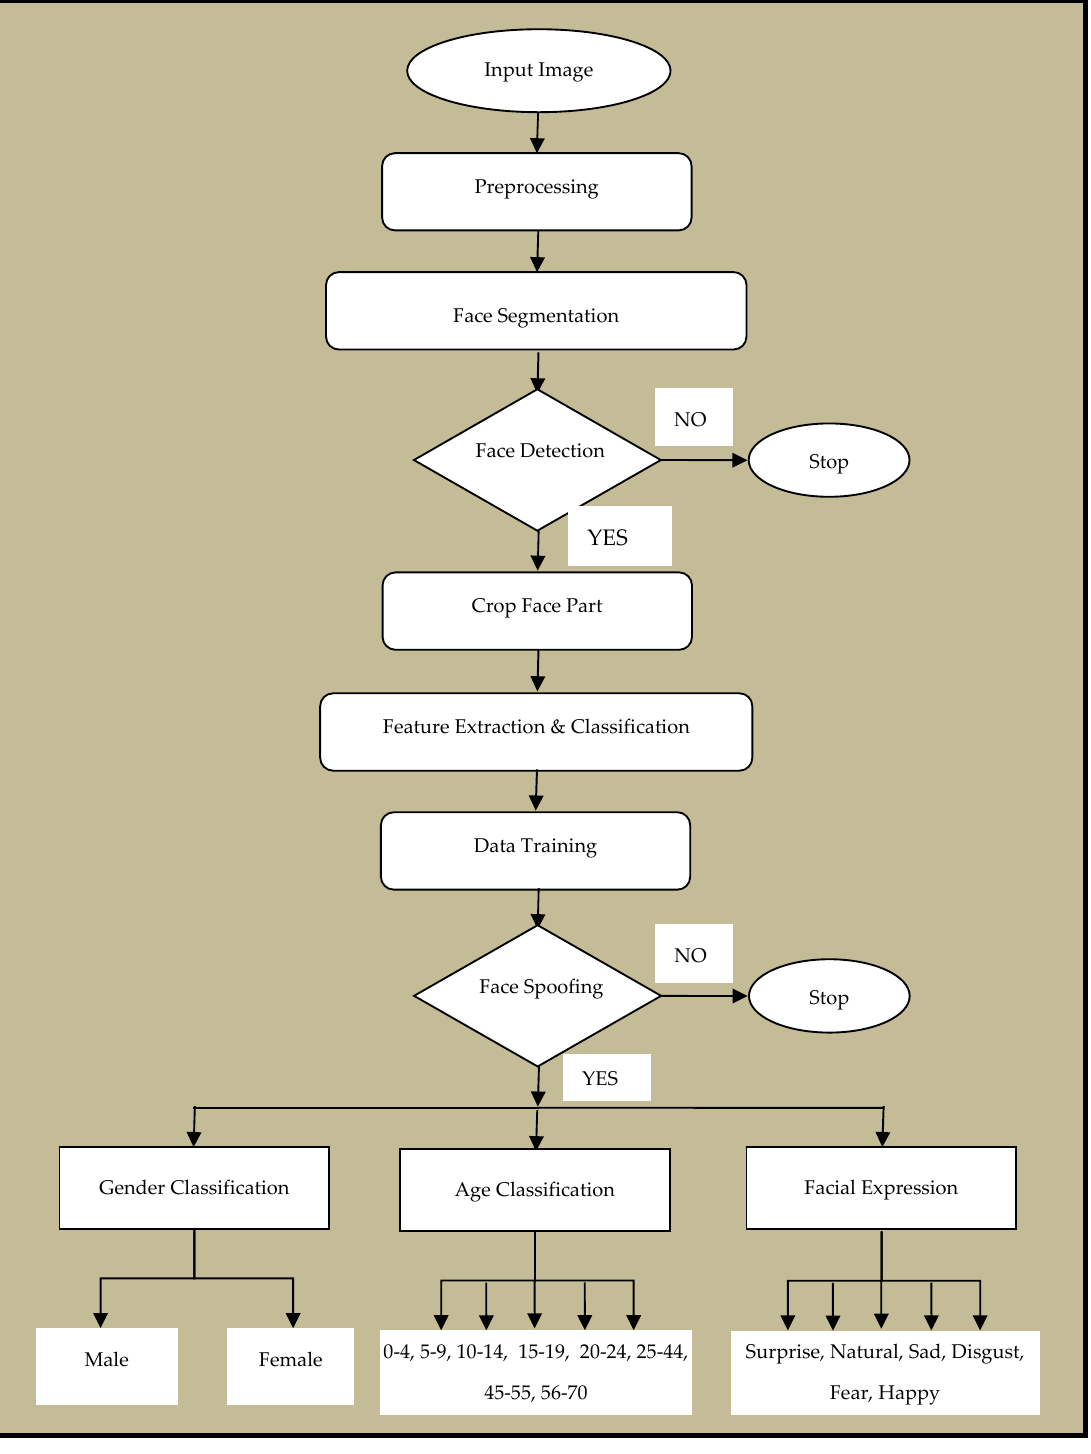
Figure 2. Flow Chart of Proposed Methodology.